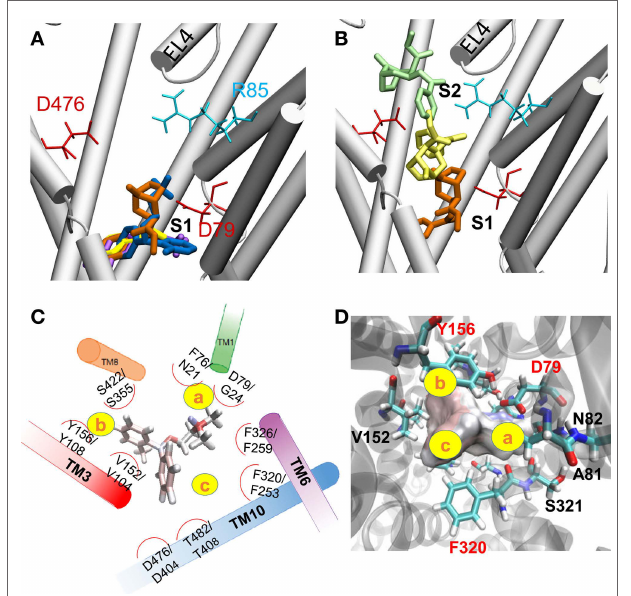
Figure 4 | substrate/drug binding to hDaT outward-facing open (OF o ) state . (a) The most favorable binding site identified for DA (magenta stick), AMPH (yellow stick), ORPH (dark blue stick), and cocaine (orange stick). The site is broadly equivalent to the nortriptyline binding site resolved in dDAT, in the close vicinity of the substrate-binding site S1. (B) Alternative cocaine binding sites identified by AutoDock. Three poses representative of three clusters are shown, with docking energies varying from -6.6 (orange) to -5.5 (yellow), to -4.8 kcal/mol (green). These binding sites span the entire EC vestibule from the entrance (near S2) to the S1 site. (c) Comparison of the binding geometry of ORPH in hDAT, and that of Leu in LeuT. All residues that are within 3 Å distance from ORPH (based on atom-atom contacts) are listed along with their LeuT counterparts (written as hDAT/LeuT residues). (D) The residues coordinating the binding of ORPH at site S1 are distributed in three subsites, labeled a–c. More detailed view of the coordination geometry of ORPH near S1, displayed from two different perspectives. ORPH is shown in surface representation.